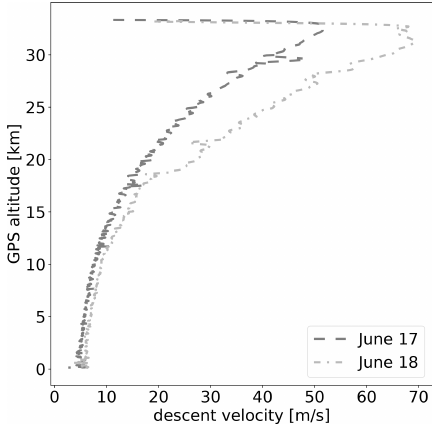
Figure 4. Descent velocities for the CO-spiking flights calculated from the GPS altitude time series on 17 June (dark, dashed line) and 18 June (light, dashed-dotted line), Traînou, 2019. The data are smoothed with a Savitzky–Golay